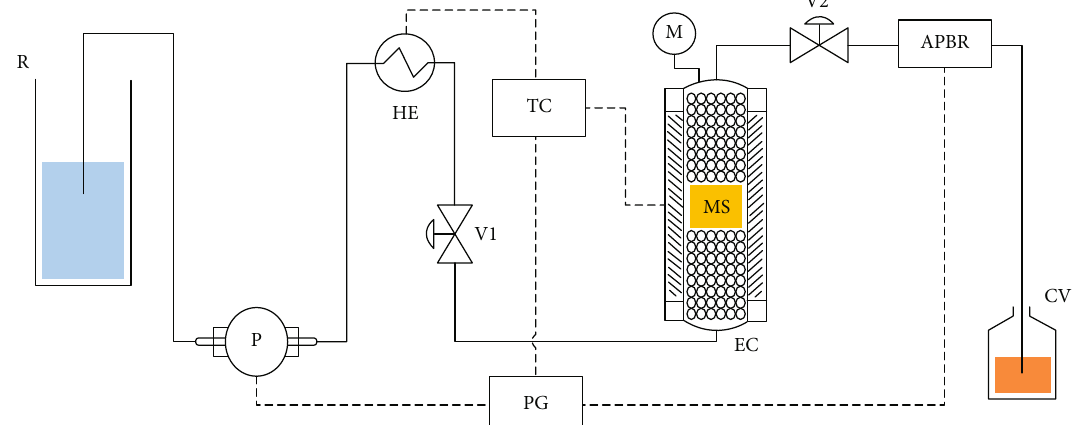
Figure 1: PLE unit scheme. R: solvent reservoir; P: solvent pump; HE: solvent heat exchanger; V1 and V2: blocking valves; EC: extraction cell; TC: temperature controller; M: manometer; ABPR: automatic back pressure regulator; CV: collecting vessel; PC: